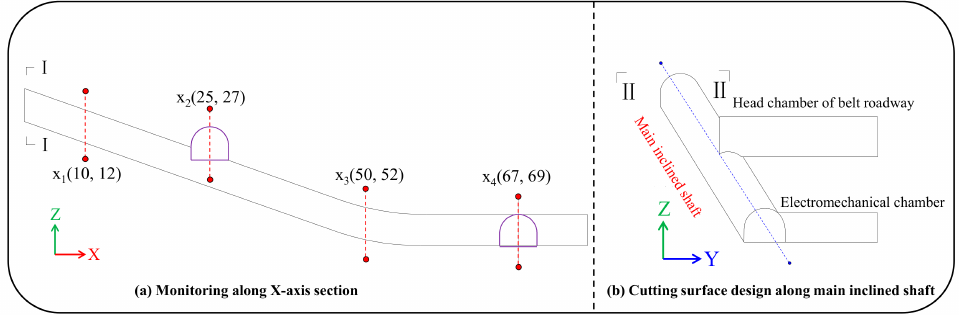
Figure 6. Model design and measuring point arrangement.